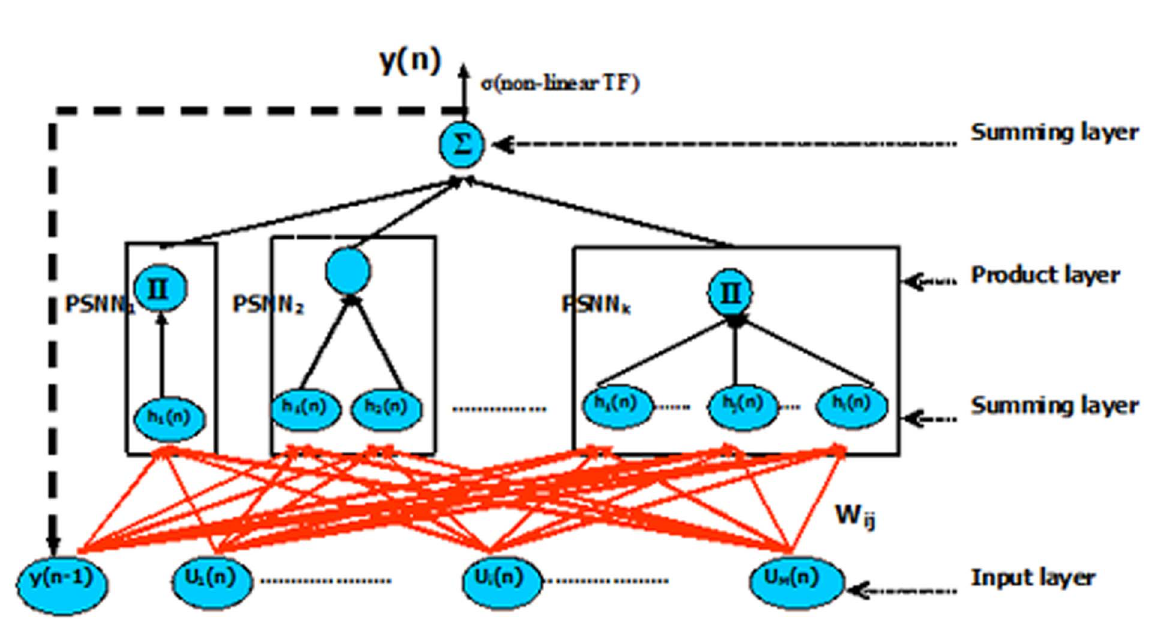
Figure 4. Dynamic Ridge Polynomial Neural Network of k -th order.